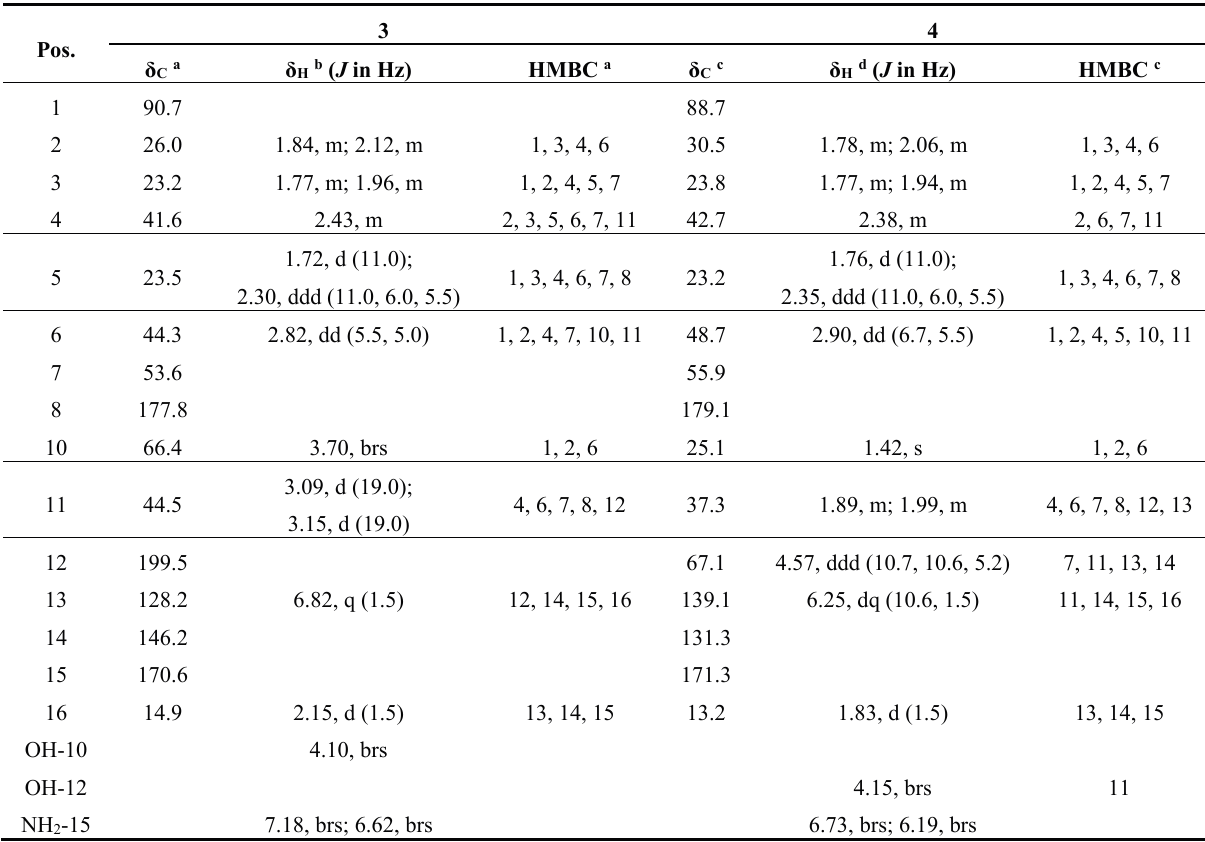
Table 2. NMR Data for 3 and 4 (Acetone- d 6 ).